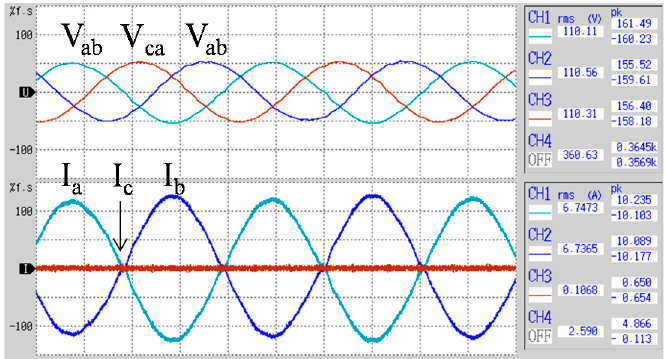
Figure 19. Waveforms of inverter output voltage and current under unbalanced load.